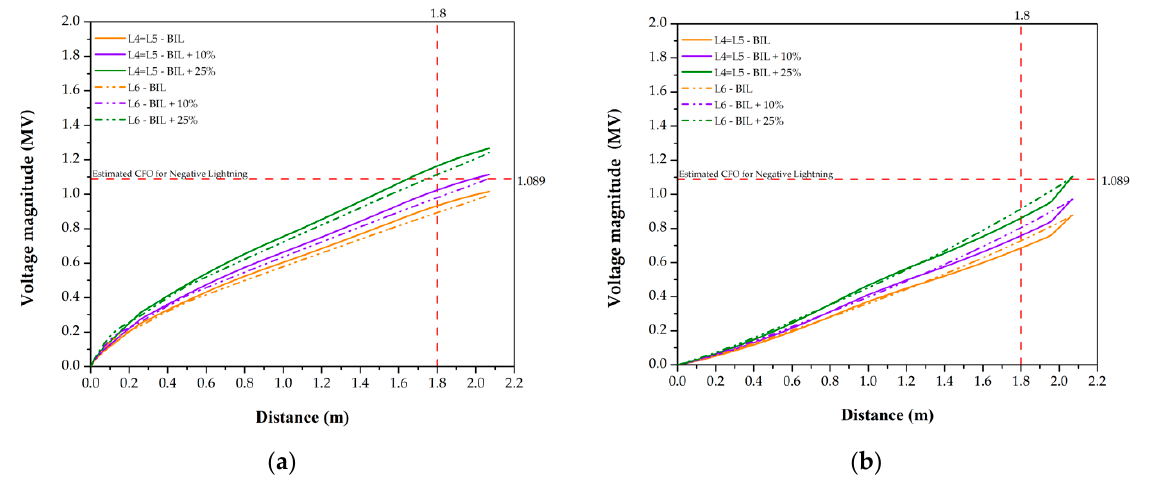
Figure 13. Voltage magnitude due to ( a ) backflashover, and ( b ) shielding failure activities. Table 11. The voltage magnitude and the percentage difference between CFO and simulation results. Phase-to-Earth Minimum Percentage Difference between Types of Overvoltages Applied BIL Clearance at Crossarm Section Estimated CFO and Simulations (%) Backflashover